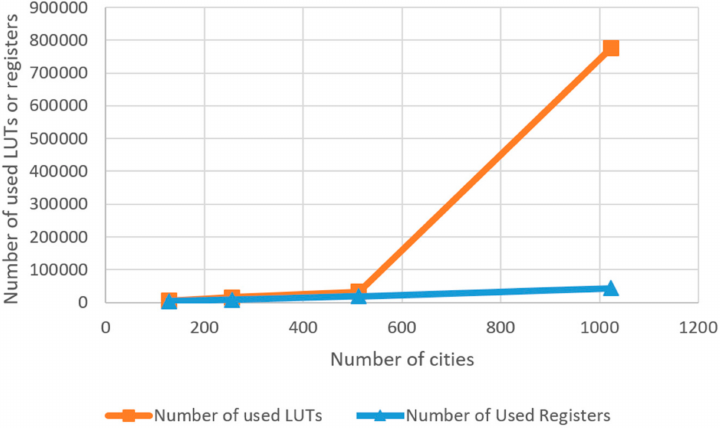
Figure 10. Register and LUT utilization of proposed